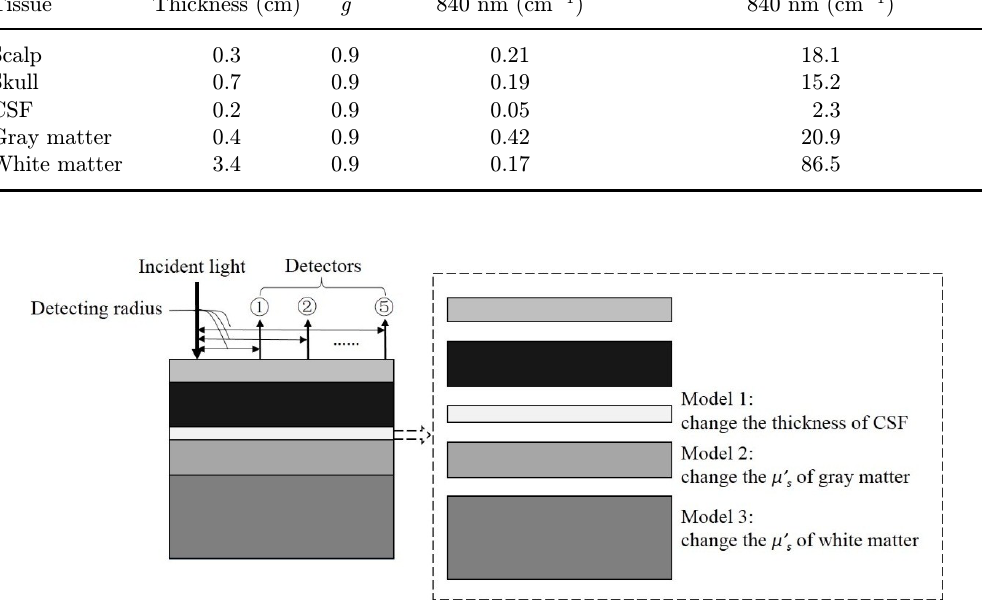
Fig. 3. Simulation model of brain